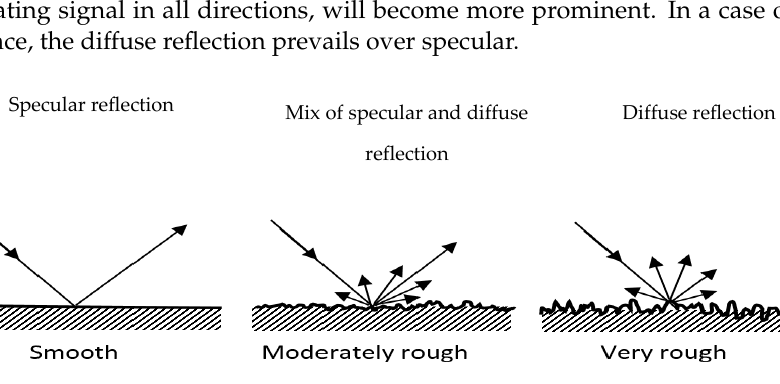
Figure 1. Reflection from smooth, moderately rough, and very rough surface.